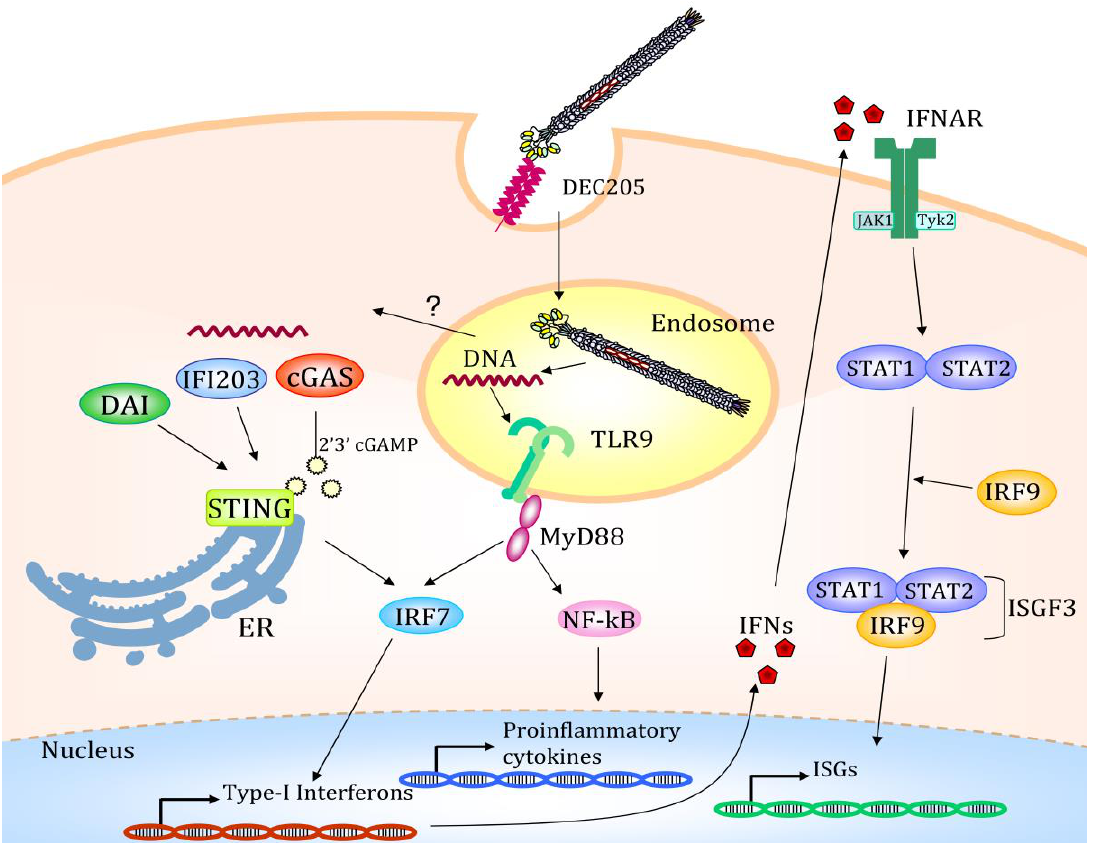
Figure 3. Once internalized via the DEC205 endocytic receptor, the filamentous bacteriophage is directed to the late endosomal compartments. Here the bacteriophage coat is degraded, and the CpG-rich DNA sequence starts the Toll-like receptor 9 (TLR9) mediated immune response with the activation of several transcription factors. A possible mechanism of endosomal escape is depicted and indicated with a question mark. Partially degraded viral DNA translocated to the cytosol starts a STING-mediated transcription activation. Type I IFNs promotes the STAT1 / STAT2 / IRF9 association to form the ISGF3 transcription factor regulating the transcription of IFN-stimulated genes (ISGs); IFNAR (Interferon-alpha / beta receptor). The figure depicts the possible scenario of target mediated fd internalization based on scientific results reported in [64,78].